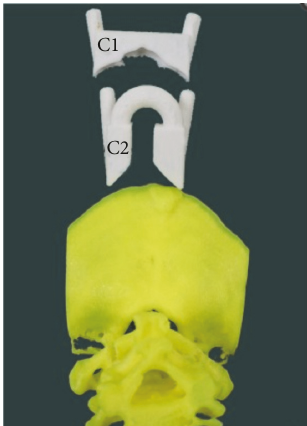
Figure 4: 3DP drill guide custom designed to fit a biomodel of 57- year-old male with atlantoaxial dislocation (source: reproduced and adapted with permission from Guo et